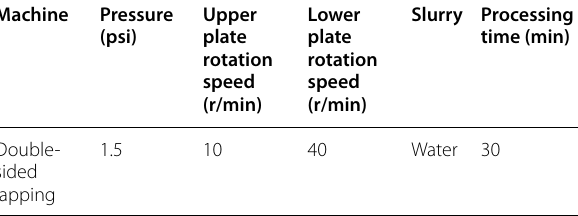
mation, and the measuring length is 190 mm. The actual measurement results and simulation results are shown in Figure 13. The maximum simulated deformation value and the measured value are compared in Table 3.